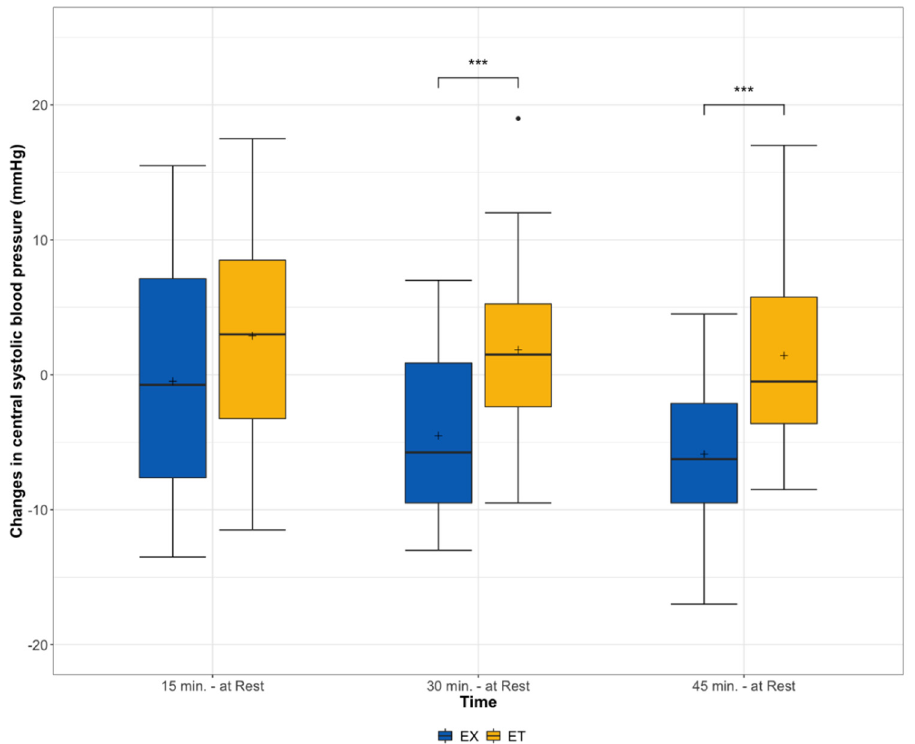
Figure 3. Changes in central systolic blood pressure from rest before and 15, 30, and 45 min after exercise stratified according to the type of exercise (ET = moderate endurance exercise, EX = exergaming session), Interaction effect *** = p < 0.001.